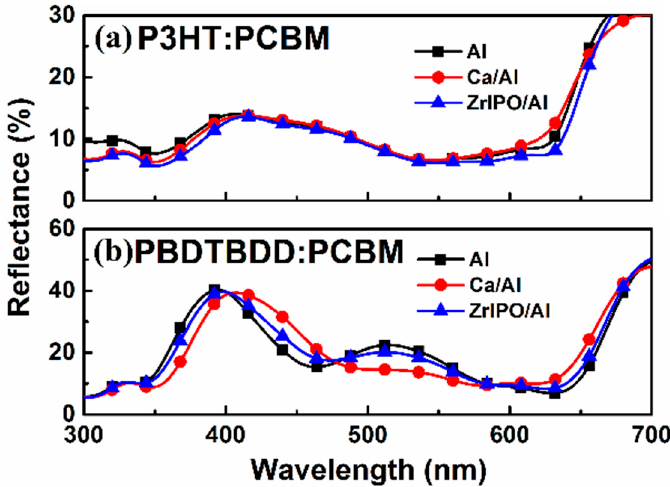
Figure 6. The reflectance spectra of PSCs based on ( a ) P3HT:PCBM and ( b ) PBDTBDD:PCBM photoactive layer with bare Al, Ca/Al and ZrIPO cathode, respectively.